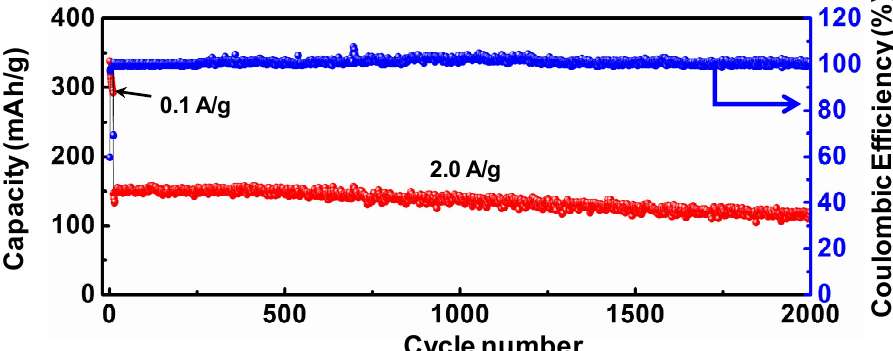
Figure 6. Cycling performance of 800-SPC material at current density of 2.0 A/g. The electrochemical behaviors were evaluated by CV measurements (Figure S10). The electrochemical behaviors were evaluated by CV measurements (Figure